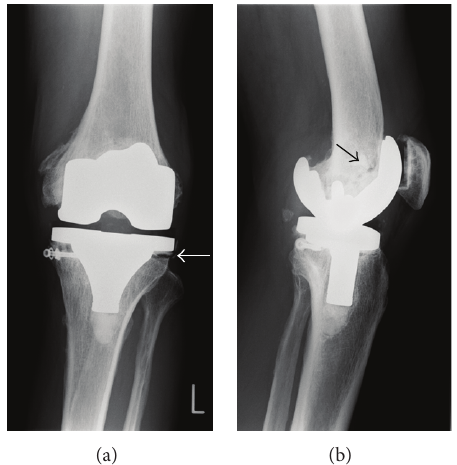
Figure 1: Radiographs of the left knee immediately after the patient sprained his knee and became unable to walk. An anteroposterior radiograph shows a radiolucency 1mm in depth beneath the lateral aspect of the tibial component ((a), arrow), and the lateral view indicates a condylar fracture ((b),